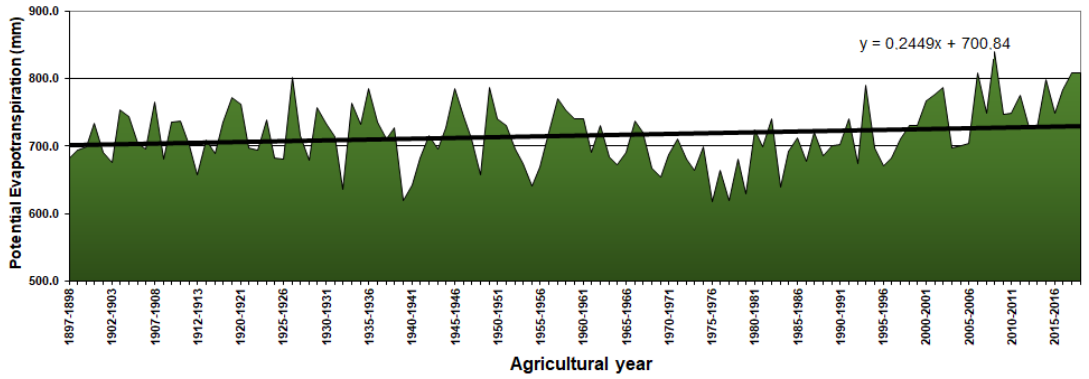
Figure 12. Annual potential evapotranspiration calculated for the Banat Plain between 1897 and 2019.